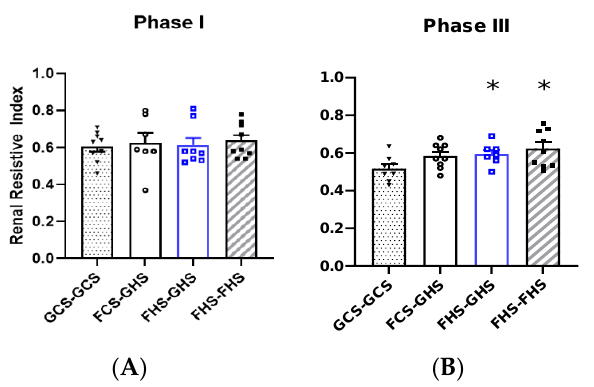
Figure 3. Renal Resistive Index at the end of Phases I and III . Renal resistive index (RRI) of the left main renal artery using doppler imaging ( A ) at the end of Phase I and ( B ) at the end of Phase III. Values are the mean ± SE; n as depicted on the graphs. * p < 0.05 vs. GCS-GCS in Phase III.